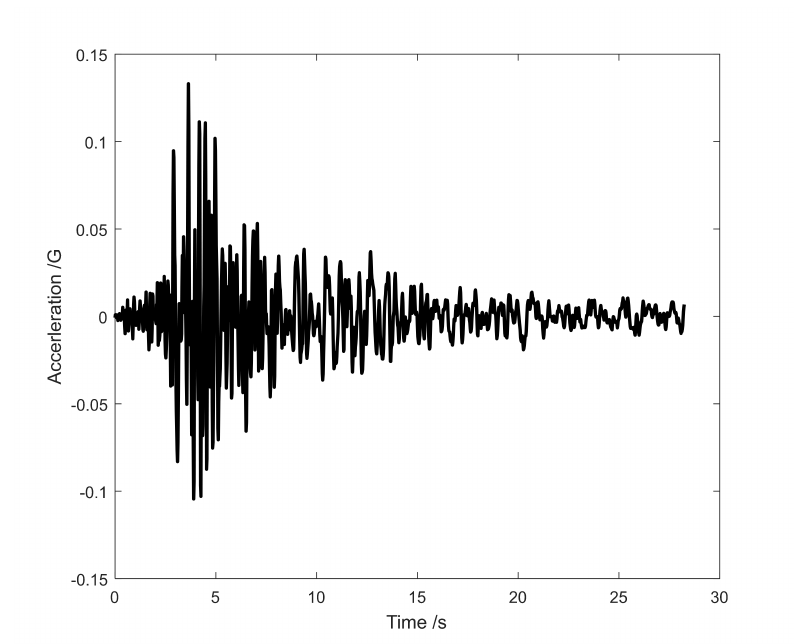
Figure 17. Acceleration history of Whittier Narrows earthquake.